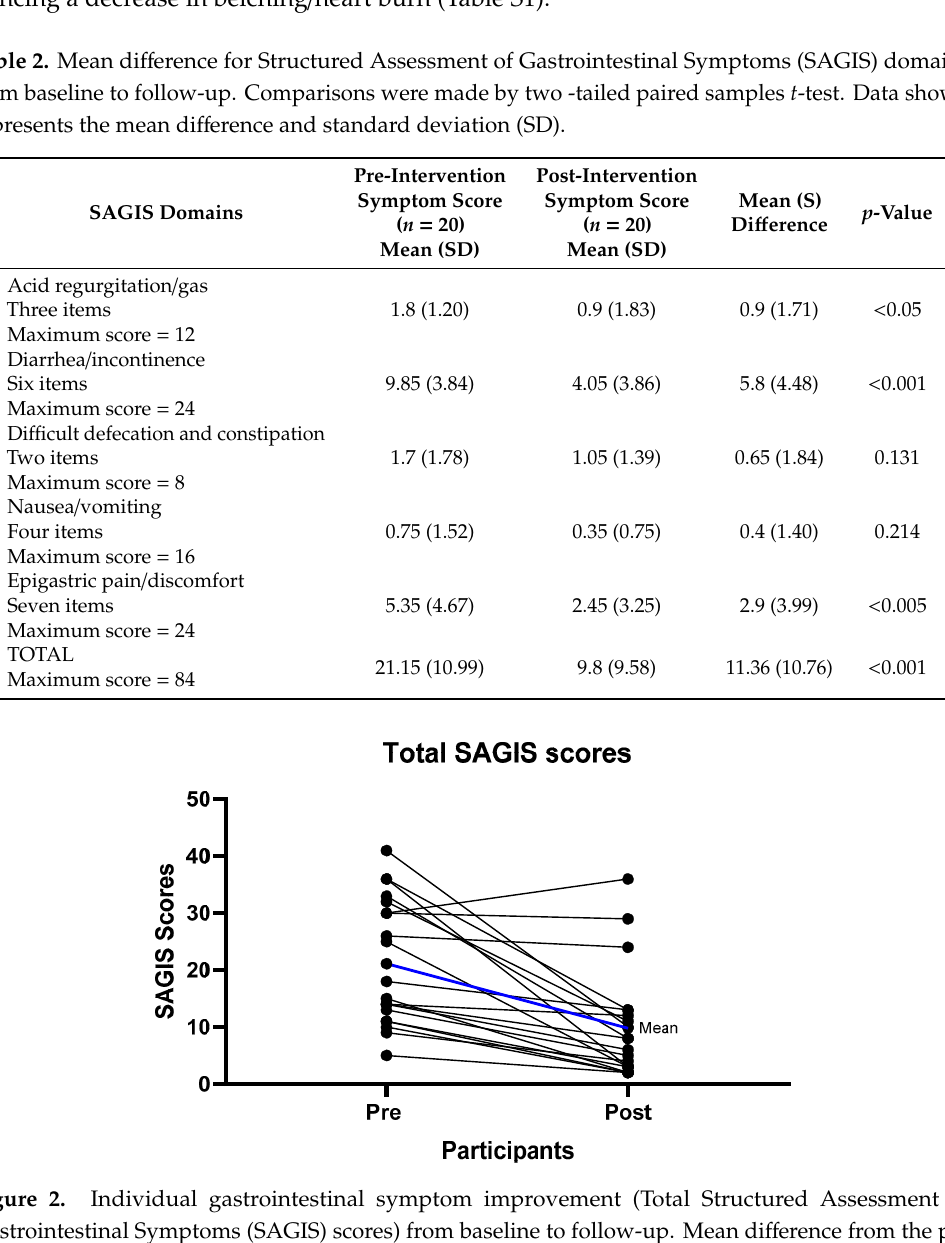
Figure 3. Individual diarrhea improvement scores from baseline to follow-up. Mean difference from the pre intervention to follow-up scores of 5.8 with a standard deviation of 4.48 p < 0.001. 3.3. Health Concerns Participants recorded their most and second most important health concern as part of the SAGIS questionnaire; 16 participants completed this question at baseline and follow-up. Thirteen participants reported that a GI symptoms such as diarrhea, GI pain, or variable bowel habit were an important concern for them at baseline. After completing phase 1 of the LFD, only seven participants reported a health concern relating to GI symptoms, the remaining participants reported that there were now no health concerns or replaced the health concern with a non-GI concern such as back pain.